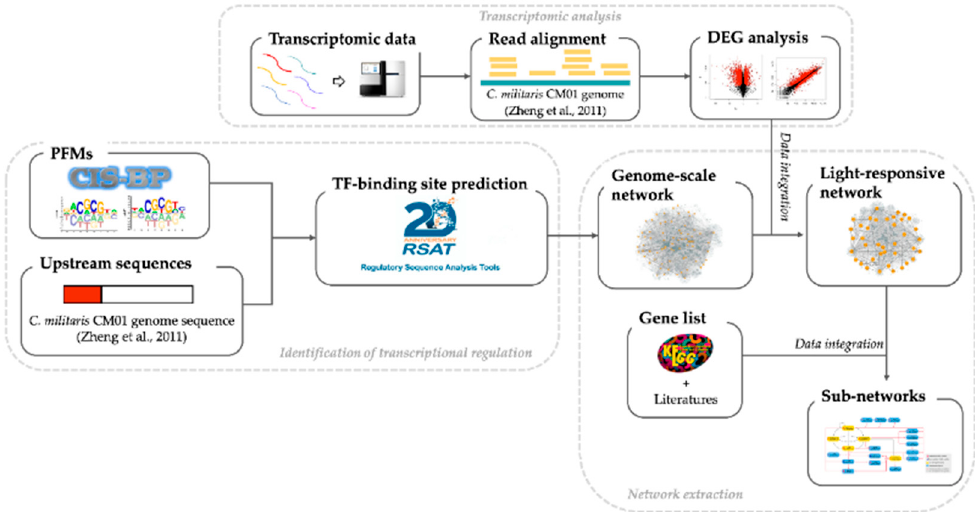
Figure 1. The overall workflow implemented in the current study. First, position frequency matrices (PFMs) of each TF of C. militaris were collected from CIS-BP. Next, Matrix-scan, a package in the Regulatory Sequence Analysis Tools (RSAT), was used to scan the upstream sequences of all C. militaris genes with each PFM to identify TF binding sites for each TF. The TF-target gene interactions were used to construct a genome-scale GRN. Then, differentially expressed genes (DEGs) under light and dark conditions from transcriptome analysis were integrated into the network to extract a light-responsive GRN. Finally, a list of genes involved in the development and carotenoid and cordycepin biosynthesis were used to extract light-responsive regulatory sub-networks.